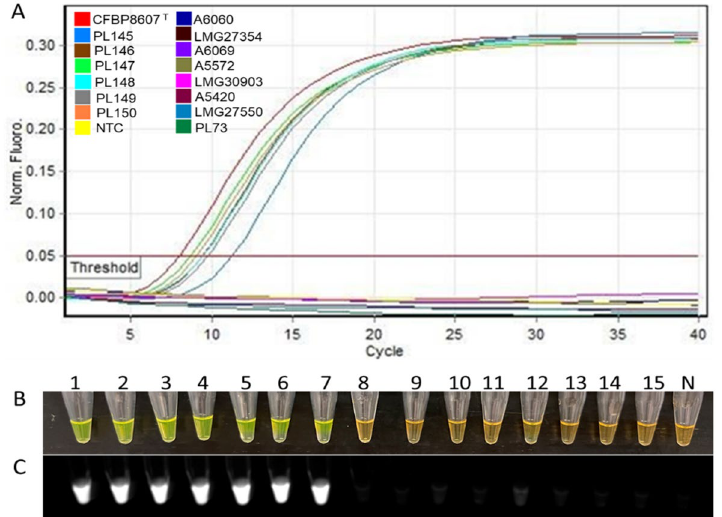
Figure 2. Specificity validation of the loop mediated isothermal amplification (LAMP) primer set designed to amplify a unique MFS transporter gene region of the Dickeya fangzhongdai . ( A ) Sigmoidal amplification curves were produced by seven D. fangzhongdai strains that formed the inclusivity panel: CFBP8607 T (positive control) and PL145, PL146, PL147, PL148, PL149, and PL150. No amplification was observed with gDNA from the strains of the exclusivity panel and non-template control (NTC; water). ( A , B ) Tube 1: CFBP8607 T ; tubes 2–7: D. fangzhongdai strains, PL145, PL146, PL147, PL148, PL149, and PL150; tubes 8–15: representative strains of the exclusivity panel: LMG27354 ( D. aquatica ), A6060 ( D. dadantii ), A6069 ( D. zeae ), A5572 ( D. dianthicola ), LMG30903 ( D. undicola ), A5420 ( D. paradisiaca ), PL88 ( D. solani ), PL73 ( Pectobacterium carotovorum ); and tube N: NTC. All reactions of gDNA template extracted from bacterial strains of the inclusivity panel produced positive results, while all reactions of the exclusivity panel failed to produce amplification. ( B ) Colorimetric detection of LAMP reaction products under ambient light after the addition of SYBR Green I dye; positive results appear green. ( C ) Detection of the fluorescent emission from the tubes with positive amplification under UV light.